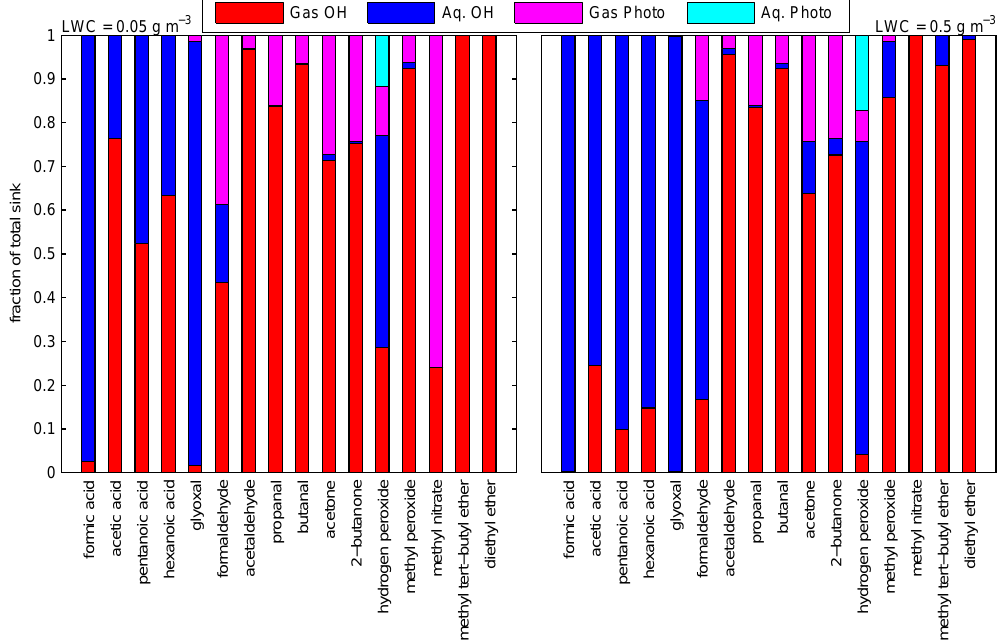
Fig. A1. Estimated magnitudes of each of the 4 chemical sinks investigated for compounds with sufficient published data. All acids are assumed to be in cloud or fog droplets at a pH = 6. Calculations were performed with a solar zenith angle of 20 ◦ . The right panel details selected species in a parcel with a LWC = 0.5gm − 3 at 273K and represents the upper limit for the contribution of aqueous processes in all situations at 273K. The left panel shows the contribution of each of the 4 sinks in an air parcel with a more realistic LWC = 0.05gm − 3 at 273K. The contributions of aqueous processes in this panel are also an upper estimate for the selected